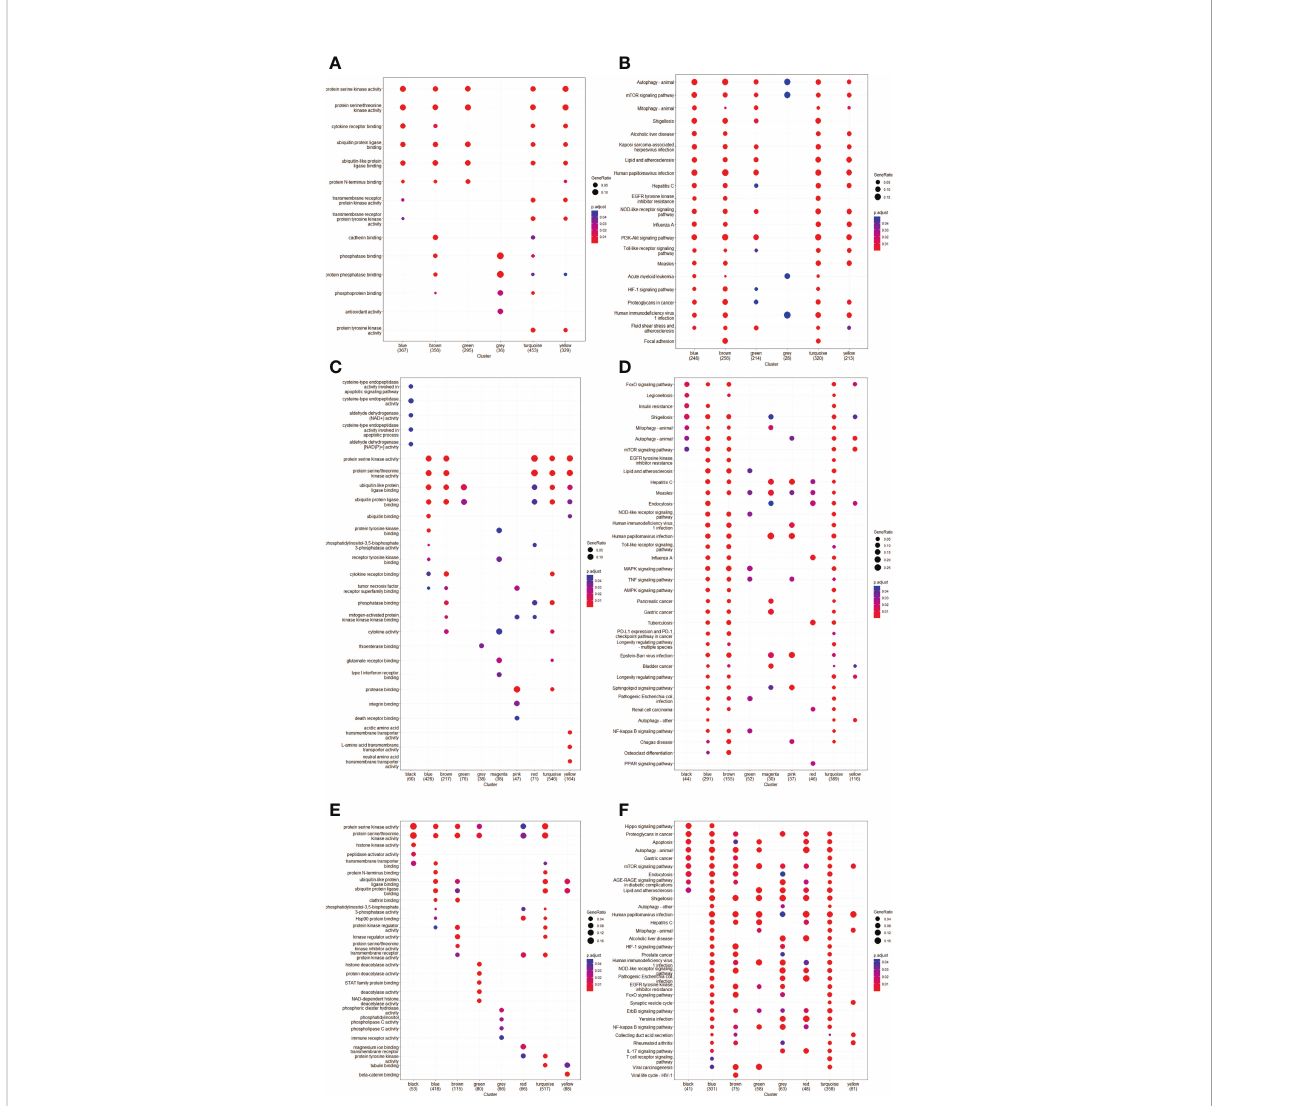
FIGURE 3 Gene ontology (GO) and Kyoto Encyclopedia of Genes and Genomes (KEGG) pathway enrichment analyses of ATGs in Key modules. (A, C, E) The GO enrichment analysis of the modules in GSE8157 (A) , GSE43264 (C) and GSE106724 (E) ; X-axis is -log10 of p -value and p < 0.05 was considered statistically signi fi cant. Y-axis shows the biological processes. (B, D, F) KEGG s ubpathway enrichment analysis of the modules in GSE8157 (B) , GSE43264 (D) and GSE106724 (F) ; X-axis is -log10 of p -value and p < 0.05 was considered statistically signi fi cant. Y-axis shows the